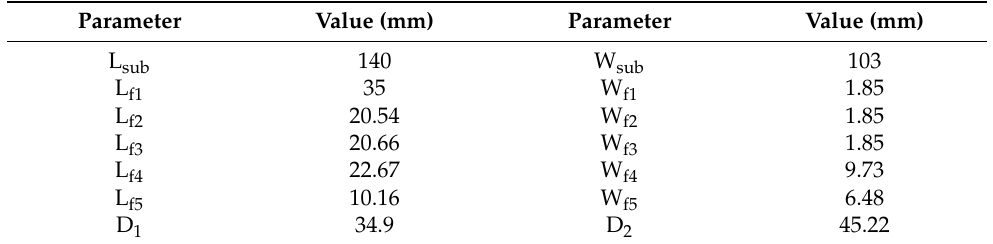
Table 1. Optimized dimensions of the proposed Rotman lens sensor operating in the mmW